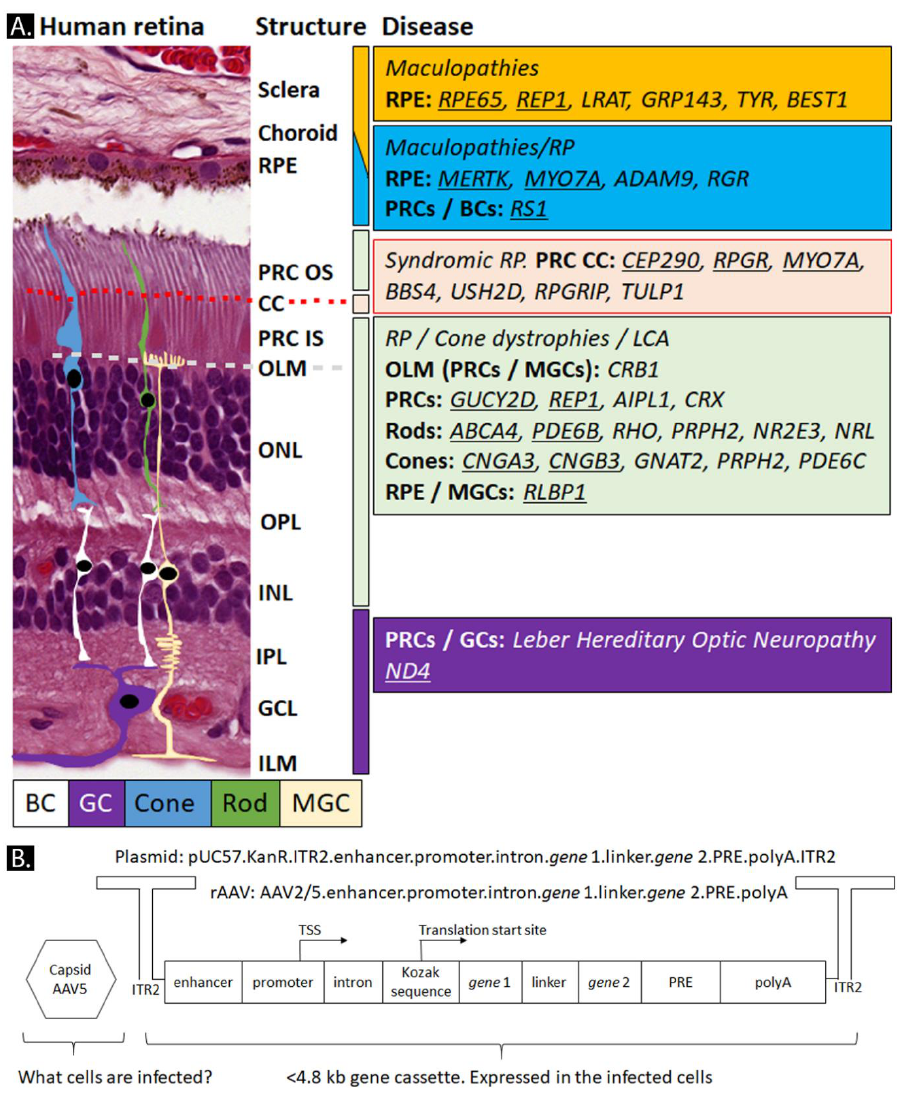
Figure 2. The development of recombinant AAV vectors targeting ocular diseases. ( A ) Main location (arrow) of frequent gene products (genes indicated) causing retinal diseases (color), and recombinant adeno-associated viral vectors (rAAV)-gene supplementation therapy genes (in clinical trials; underlined genes). ( B ) Hypothetical rAAV gene cassette and the corresponding plasmid. AAV5, adeno-associated viral vector serotype 5; BC, bipolar cell; Cone, cone photoreceptor; CC, connecting cilium; GC, ganglion cell; GCL, Ganglion Cell Layer; ILM, Inner Limiting Membrane; IPL, Inner Plexiform Layer; ITR, inverted terminal repeat; KanR, kanamycin resistance gene; LCA, Leber congenital amaurosis; MGC, Müller glial cell; ONL, outer nuclear layer; OPL, Outer Plexiform Layer; PRC IS, photoreceptor inner segment; PRC OS, photoreceptor outer segment; polyA, polyadenylation sequence; PRE, post-transcriptional gene regulatory element; RP, retinitis pigmentosa; RPE, retinal pigment epithelium; rod, rod photoreceptor; TSS, transcription start site.